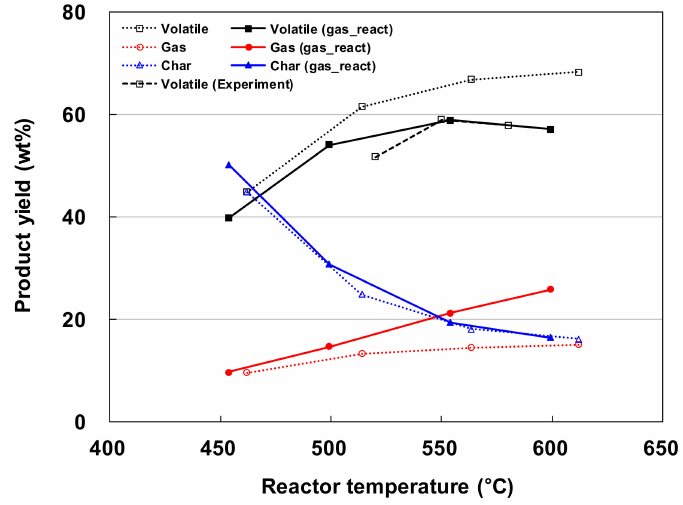
Figure 5. Product yields from fast pyrolysis of co ff ee ground at various reactor